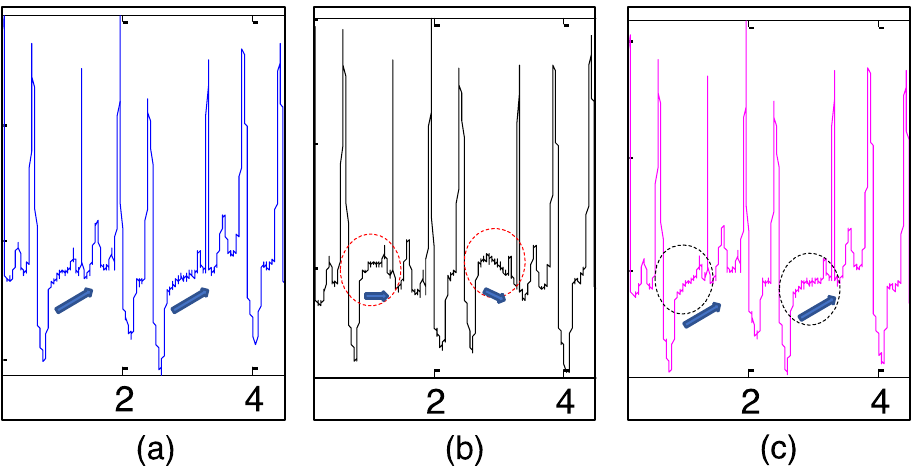
Figure 5. The comparison in detail from Figure 4, with the first few heartbeats included. ( a ) Original ECG in Figure 4a. ( b ) BW corrected ECG using the CFF R − wave in Figure 4b. ( c ) BW corrected ECG using the CFF dct in Figure 4c.